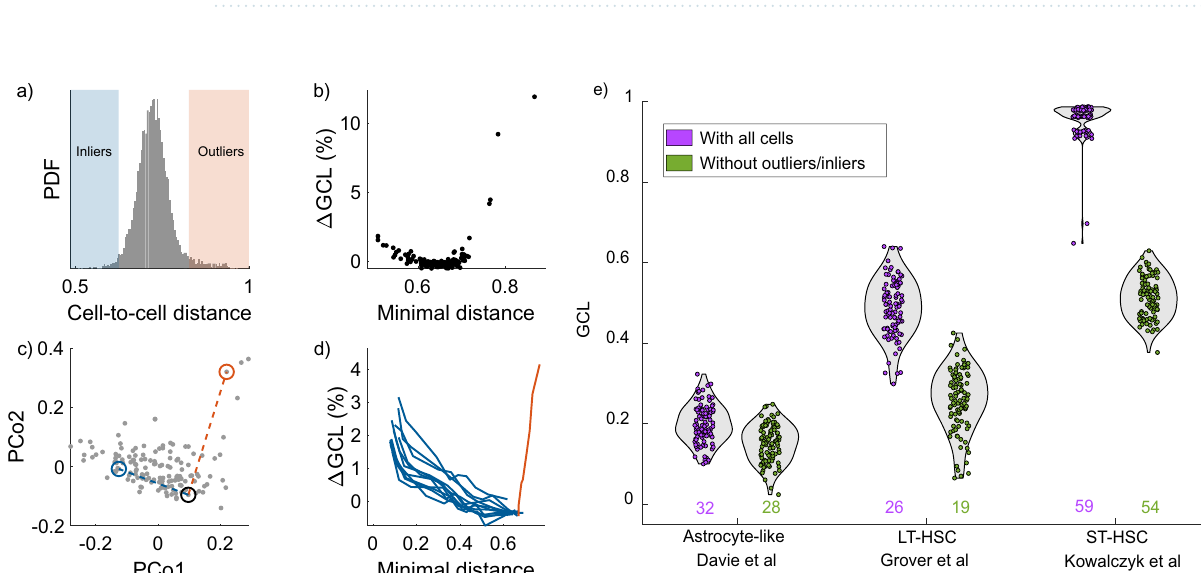
Table 1. List of the data-sets used in this work. The data-sets are freely available online and the experimental and bioinformatics processes are detailed in the original publications.